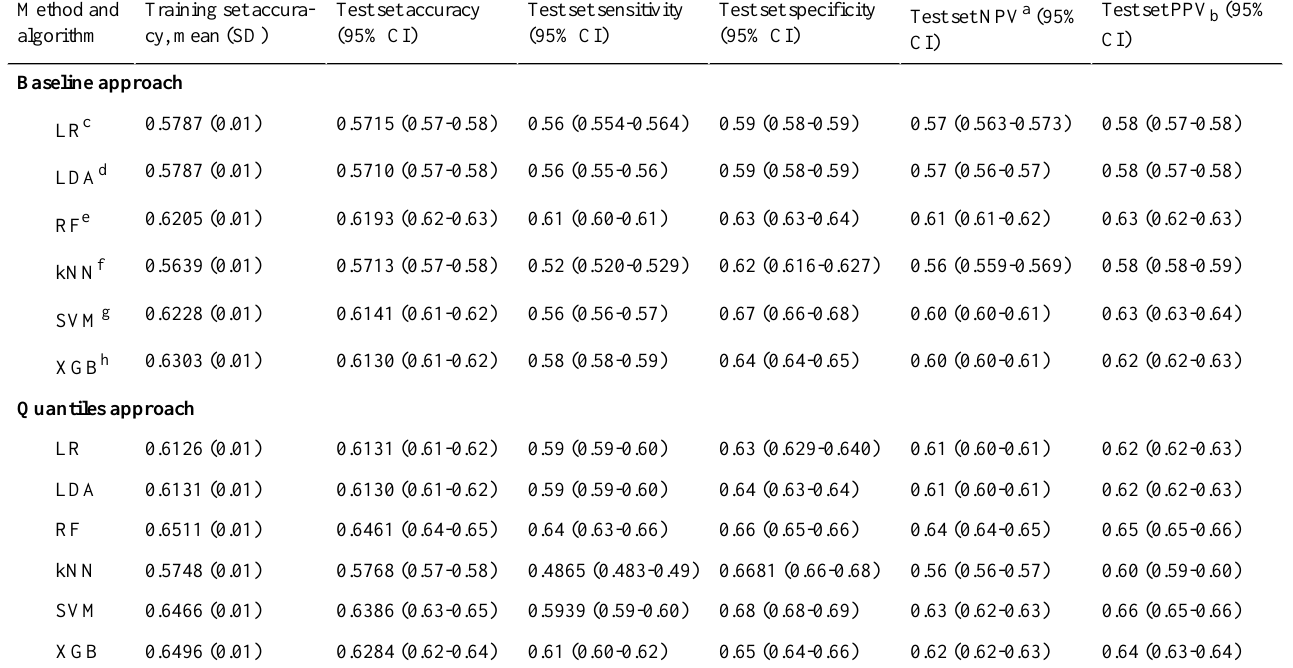
Table 10. Length of stay model results for six algorithms using different performance